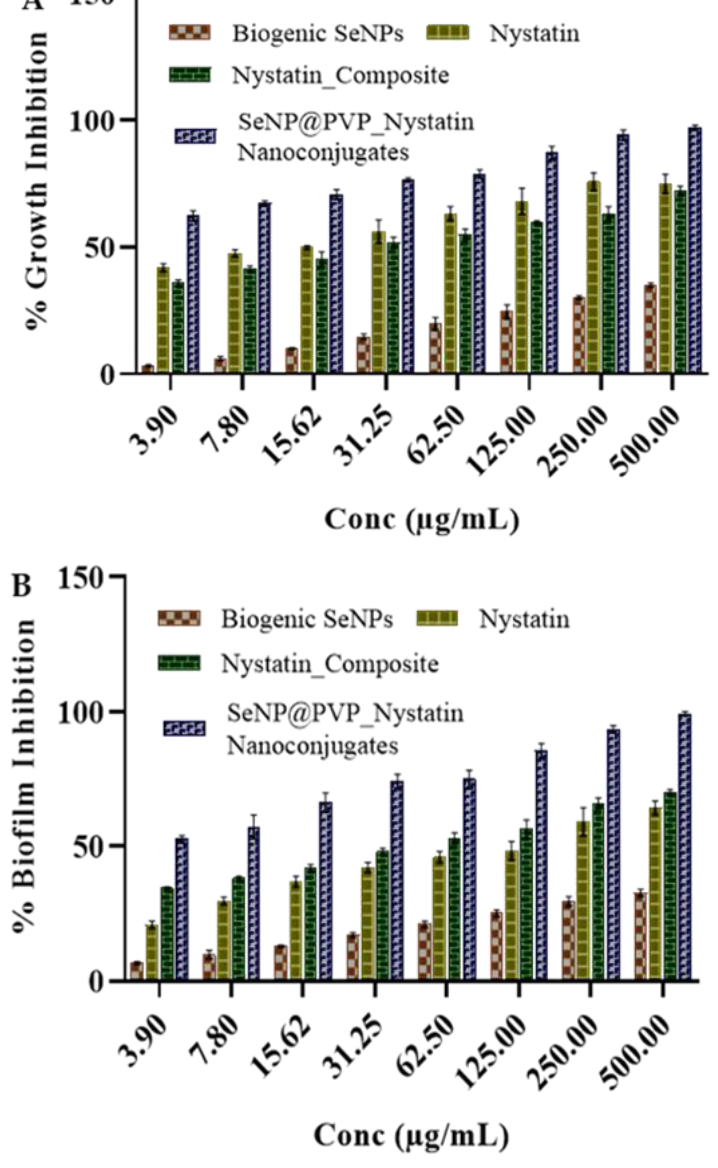
Figure 5. Antifungal activity of biogenic SeNPs, Nystatin_Composites, and SeNP@PVP_Nystatin nanoconjugates on C. albicans . Nanoconjugates showed better antifungal activity (inhibition of growth ( A ) and biofilm ( B )) than composites, and biogenic SeNPs did not show growth inhibition activity up to 500 μg/mL.